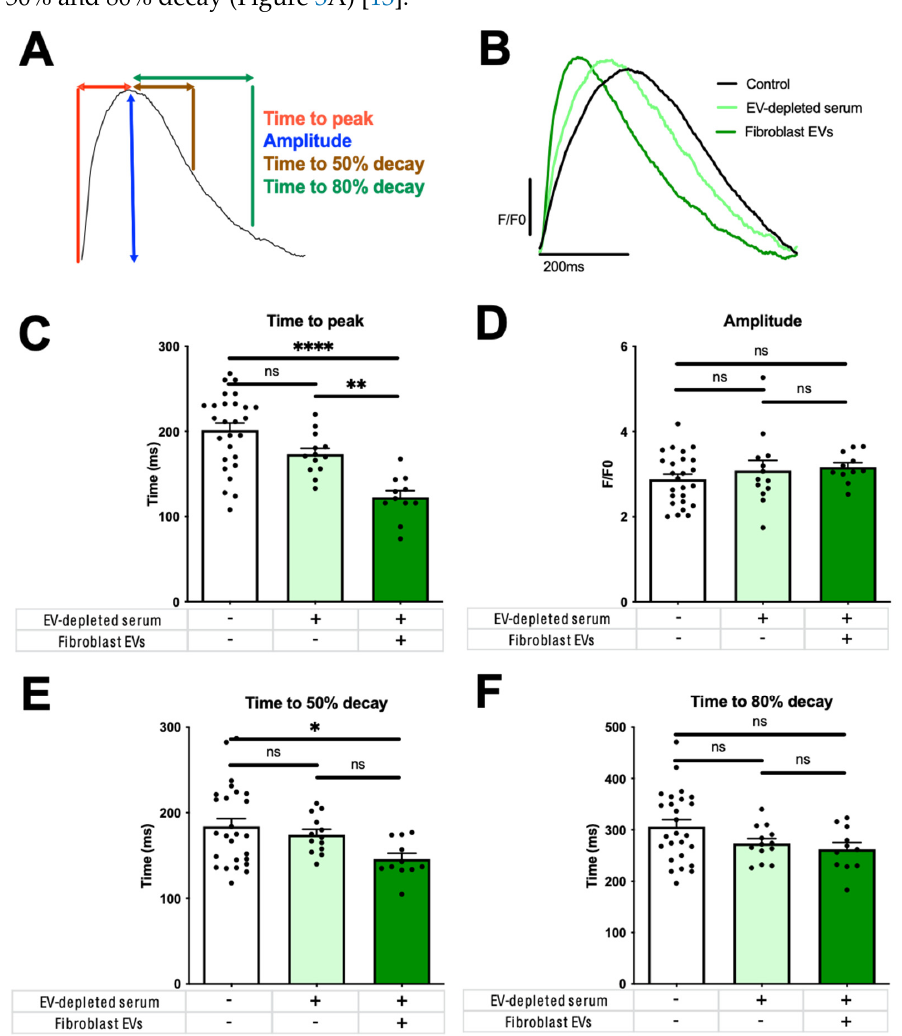
Figure 3. Modulation of human cardiomyocyte Ca 2+ cycling by fibroblast-secreted extracellular vesicles (EVs). ( A ) Human induced pluripotent stem cell-derived cardiomyocyte (hiPSC-CM) Ca 2+ transient parameters measured were time to Ca 2+ transient peak as an indicator of Ca 2+ -induced Ca 2+ -release efficiency; amplitude as an indicator of cytosolic Ca 2+ availability, and time from peak to 50% and 80% decay as an indicator of the efficiency of cytosolic Ca 2+ removal mechanisms. hiPSC-CMs were field-stimulated at 1 Hz. ( B ) Representative traces of control (serum-free media) (black line in B or white bar in C-F), EV-depleted fibroblast maintenance media (Dulbecco’s Modified Eagle Medium, 2% v / v exosome-depleted Foetal Bovine Serum, 1% v / v Penicillin-Streptomycin) in the absence of fibroblast EVs (light green) and conditioned with fibroblast EVs (150 µg) (dark green). Individual parameters were Ca 2+ transient ( C ) time to peak; ( D ) amplitude and time from peak to ( E ) 50% decay and ( F ) 80% decay. Error bars represent SEM. Control N = 7, EV-depleted serum N = 4, Fibroblast EVs N = 4 biological replicates of hiPSC-CMs. Fibroblast EVs taken from four diseased human hearts. n = 4 technical replications. One, three and five preparations of control, EV-depleted serum and fibroblast-EVs conditions, respectively, were not suitable for experiments due to human or technical error. * = p < 0.05, ** = p < 0.01, **** = p < 0.0001.